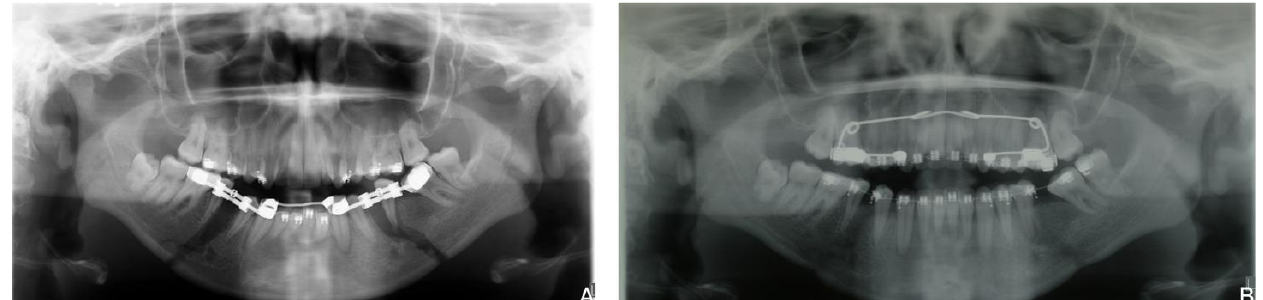
Figure 4. Intra oral mandibular photography before ( A ) and after the distraction osteogenesis ( B ) with dento-anchored distractor.